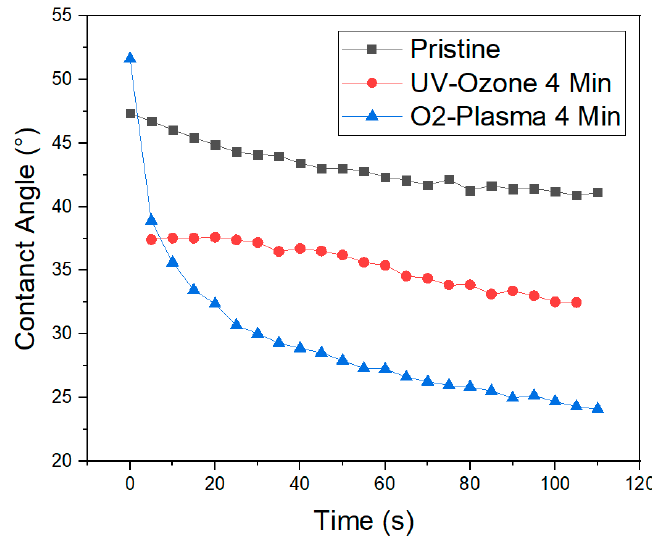
Figure 3. Contact angle measured on an untreated, pristine cured polymer layer (black line), a sample after a four-minute UV-Ozone treatment (red line) and a sample after a four-minute O 2 plasma activation (blue line). The WCA was measured every five seconds, and the graph shows its evolution along time for the three different samples.